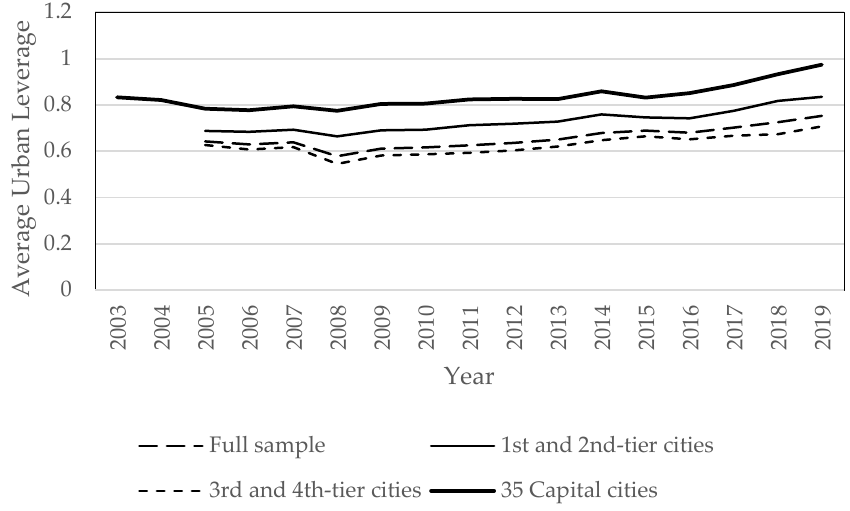
Figure 1. Average urban leverage ratios from 2003 to 2019.